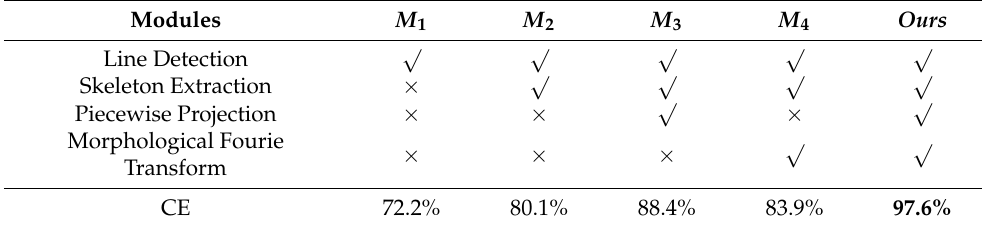
Table 8. Evaluation results of method